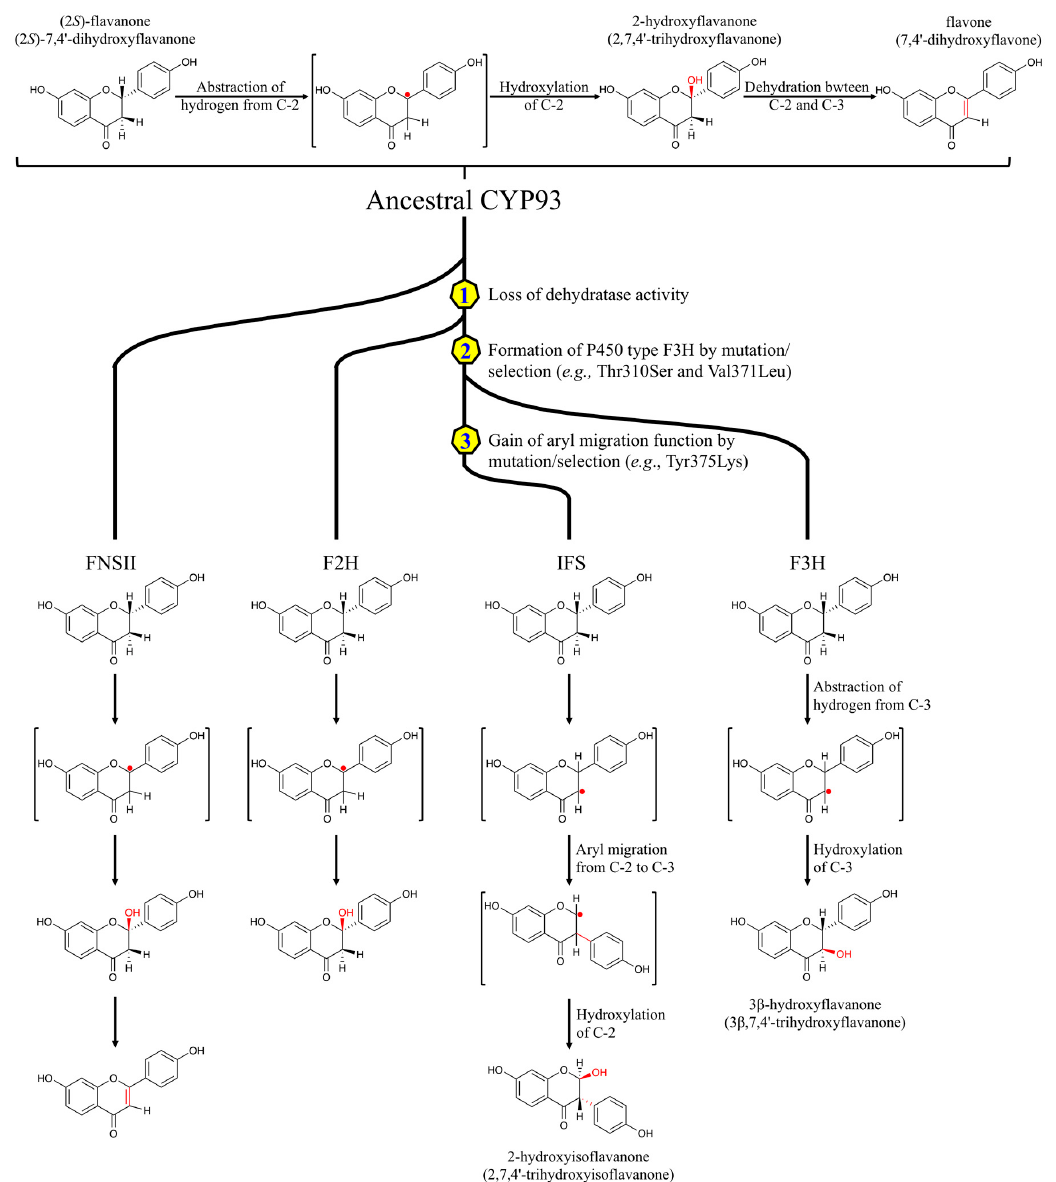
Figure 3. Proposed molecular evolutionary process of FNSII, F2H, IFS, and F3H from an ancestral CYP93 [43,46]. Amino acid numbers refer to positions in CYP93C2. FNSII: flavone synthase II; F2H: flavanone 2-hydroxylase; IFS: 2-hydroxyisoflavanone synthase; F3H: flavanone 3 β -hydroxylase.